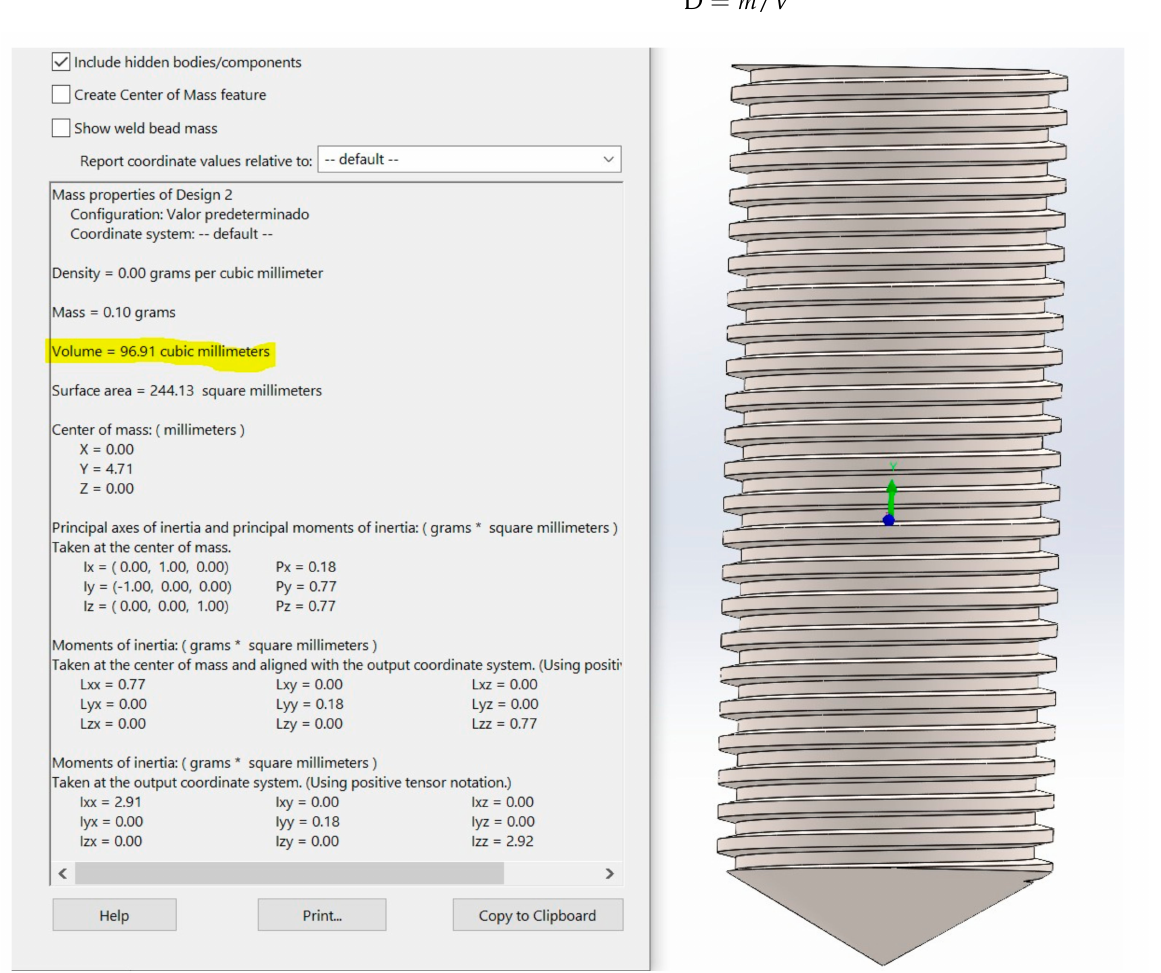
Figure 2. Complete model with a volume equal to 96.91 mm 3